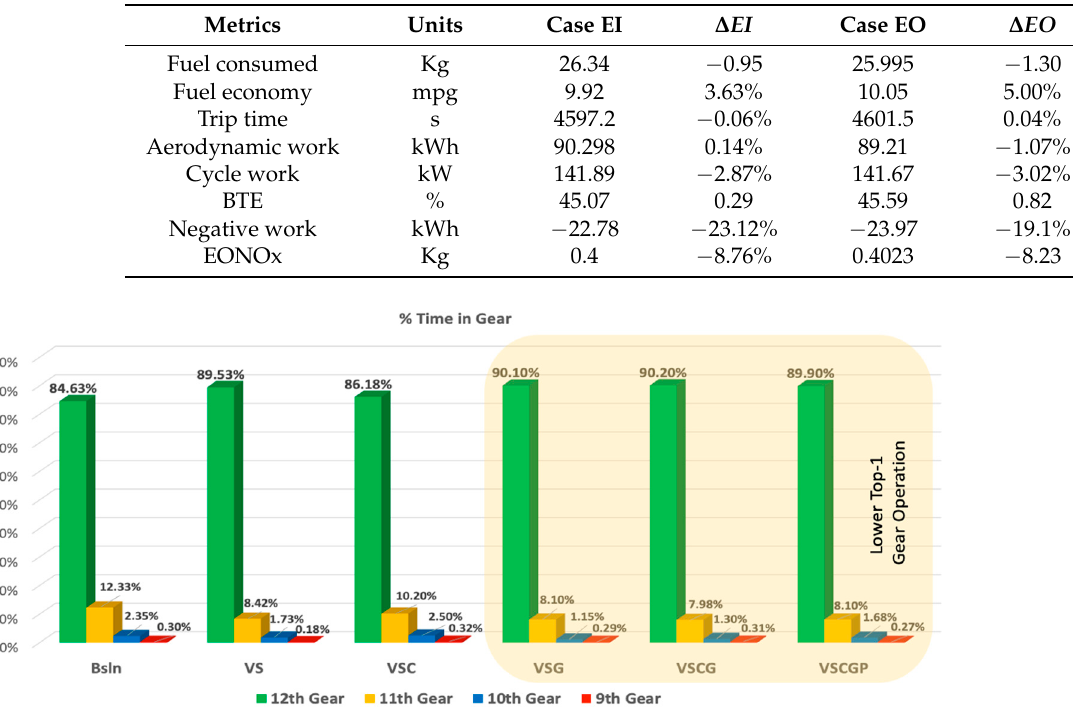
Figure 7. % Time in top 4 gears for each DOE. The comparison must be between the top 2 gears. Predictive gear tries to operate more at a lower gear while fuel economy tends to operate at a higher